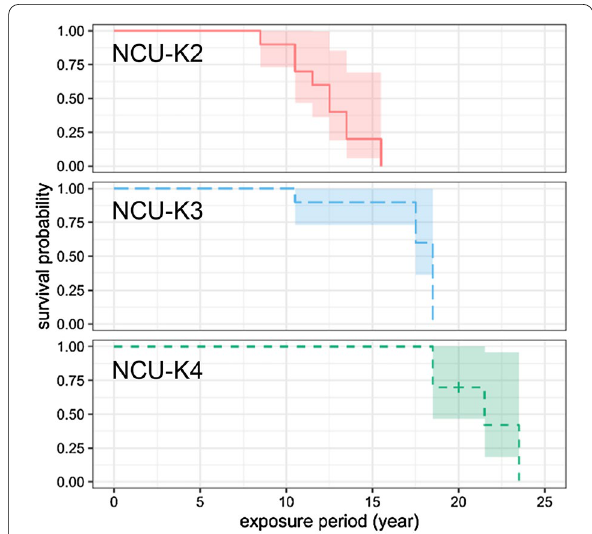
Fig. 2 Kaplan–Meier curves for stakes impregnated with NCU-E at different performance classifications. Information on the stakes is shown in Table 1. NCU-E emulsified copper naphthenate